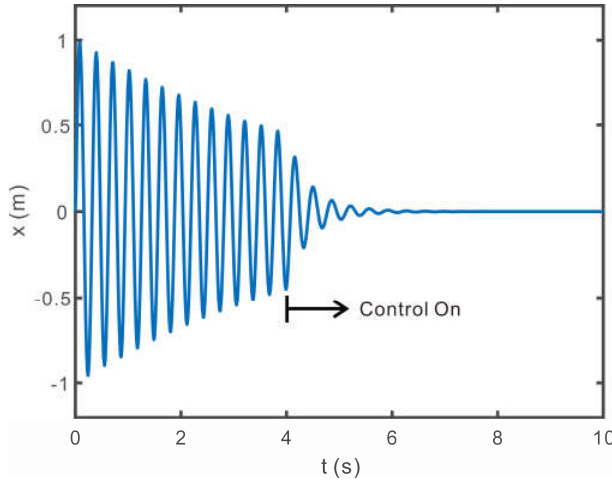
Figure 6. The time history of displacement.